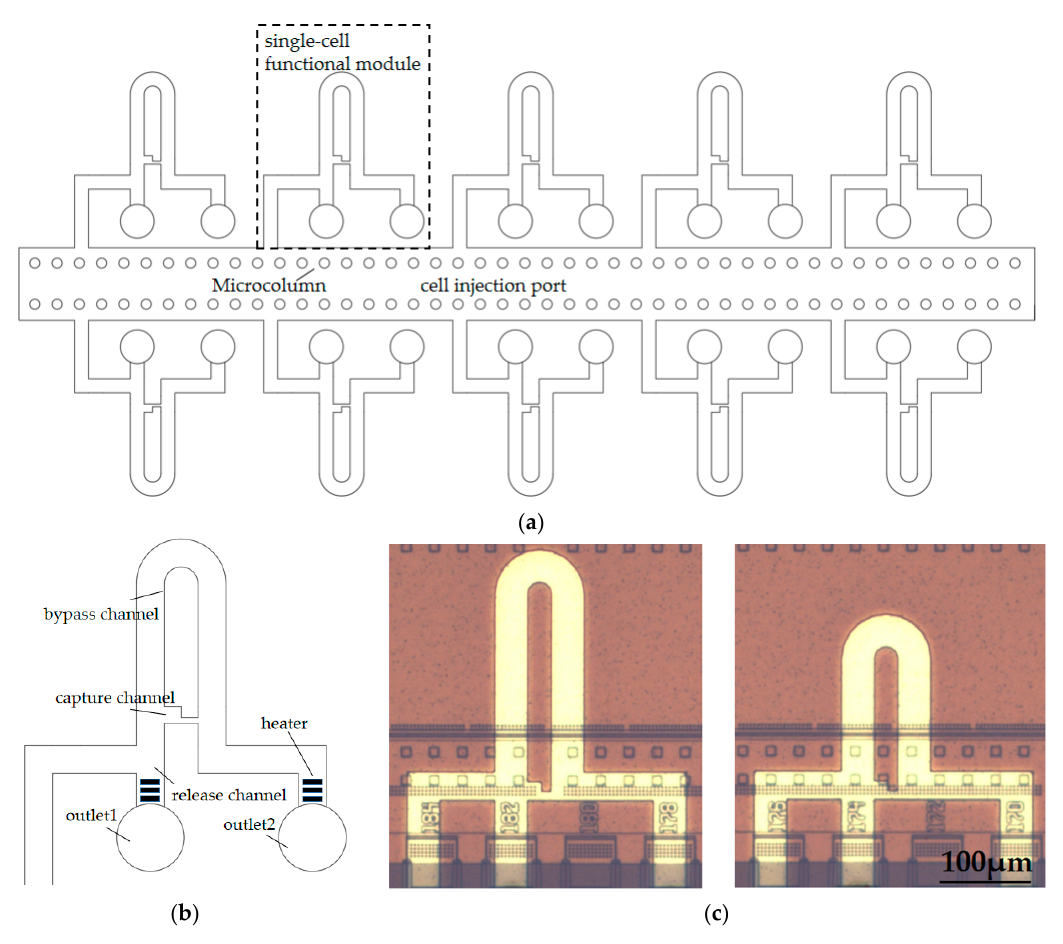
Figure 1. Integrated micro fl uidic chip for single-cell isolation and release. ( a ) A schematic diagram of the micro fl uidic chip’s three components (cell injection port, single-cell functional modules, and microcolumn array); ( b ) A single-cell functional module for cell capture and release; ( c ) Photographs of the two di ff erent channels.